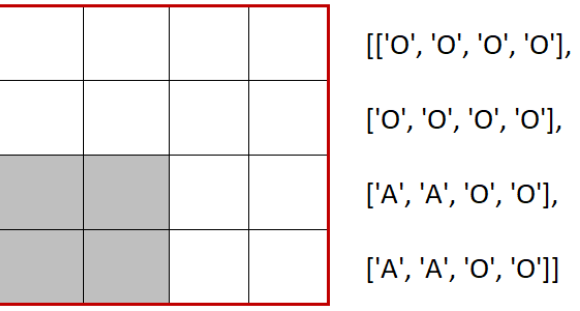
Figure 6. Data structure of the BG: a 70% office—25% atrium representation.